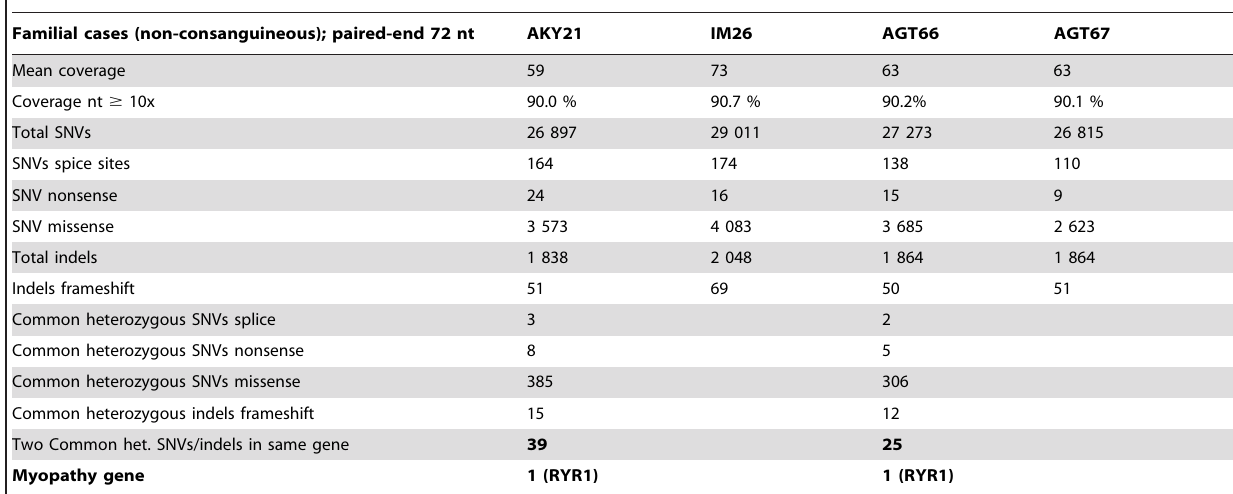
Table 3. Statistical overview of the exome sequencing results: familial cases (non-consanguineous) AKY21/IM26 and AGT66/ AGT67.